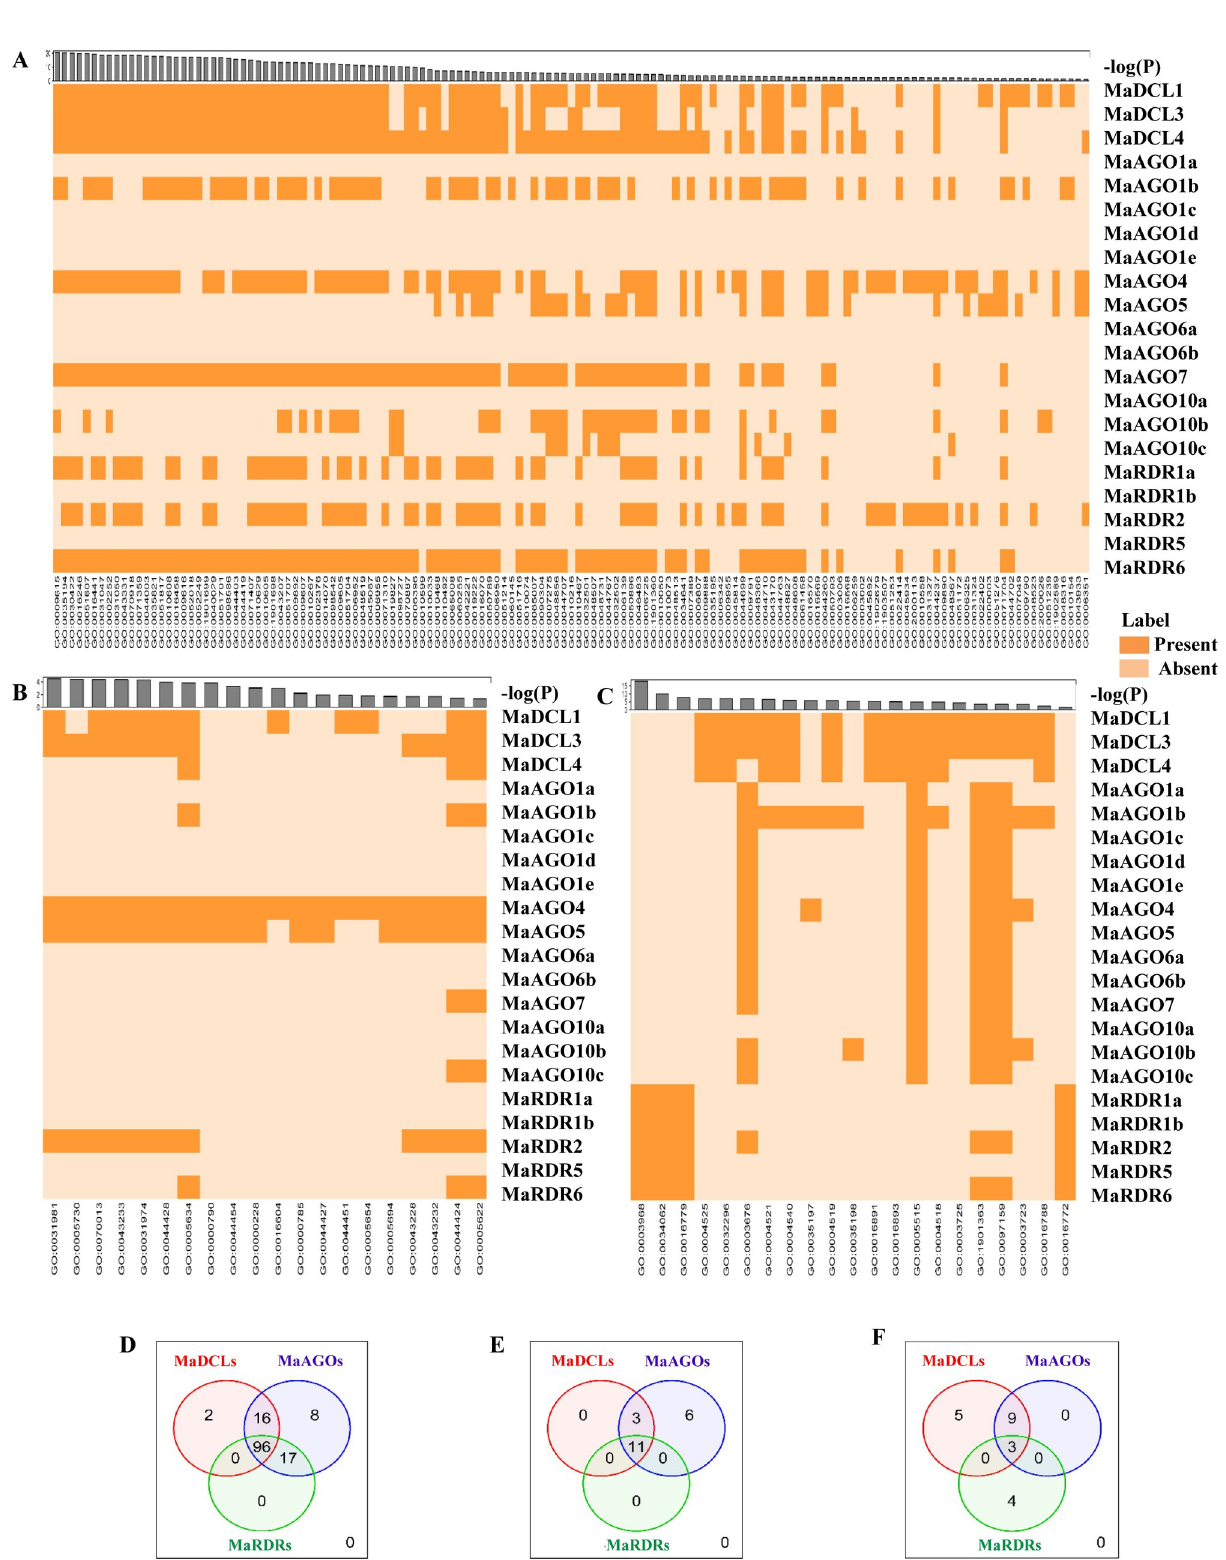
Fig 10. The Heatmap for the predicted GO terms corresponding to the predicted RNAi genes is represented for (A) biological process (B) cellular components and their association to the genes whether they are present or absent. The p -value corresponds to the GO terms are shown in the histogram